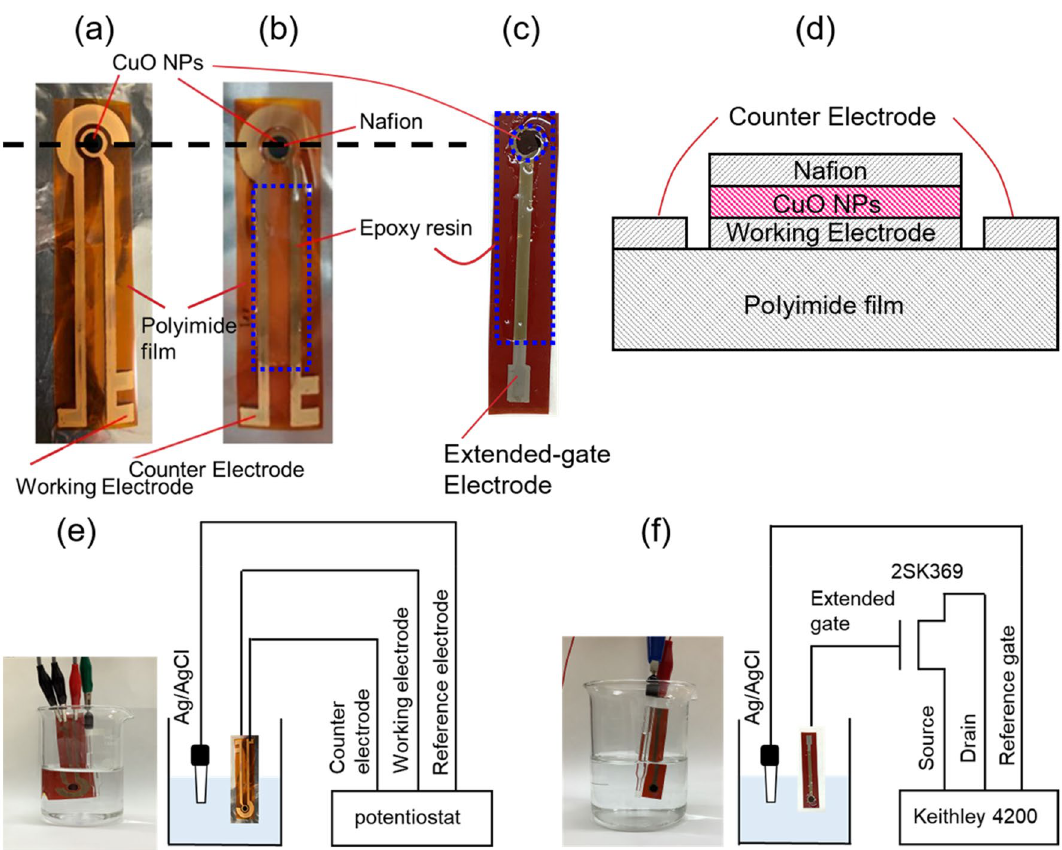
test. The inset photograph shows the connections between the electrodes and the potentiostat device and the reference elec- trode. f The measurement setup for the extended-gate field-effect transistor configuration. The source and the drain electrode of the FET device are connected to the semiconductor parameter ana- lyzer (Keithley 4200). The inset photograph shows the connections between the extended-gate electrode and the FET device with the reference